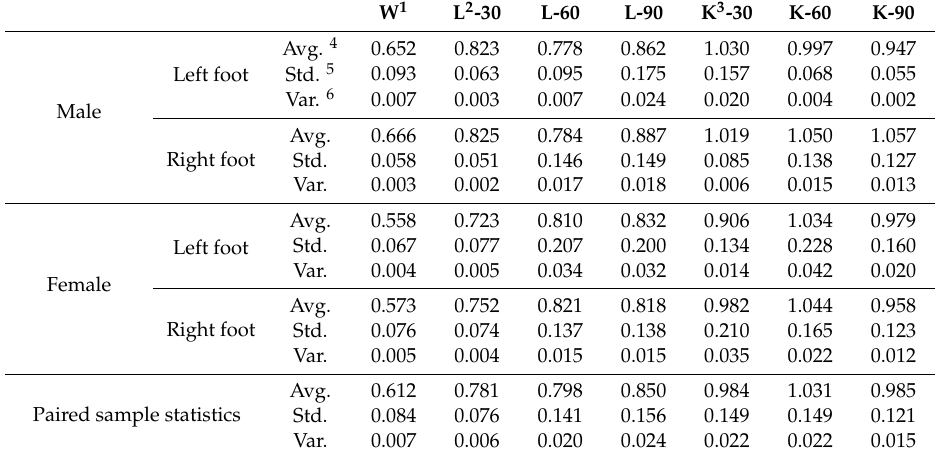
Table 1. Observation summary on the ratio of VMO/VL muscle strength in walking and lifting legs/kicking legs at 30 ◦ , 60 ◦ , and 90 ◦